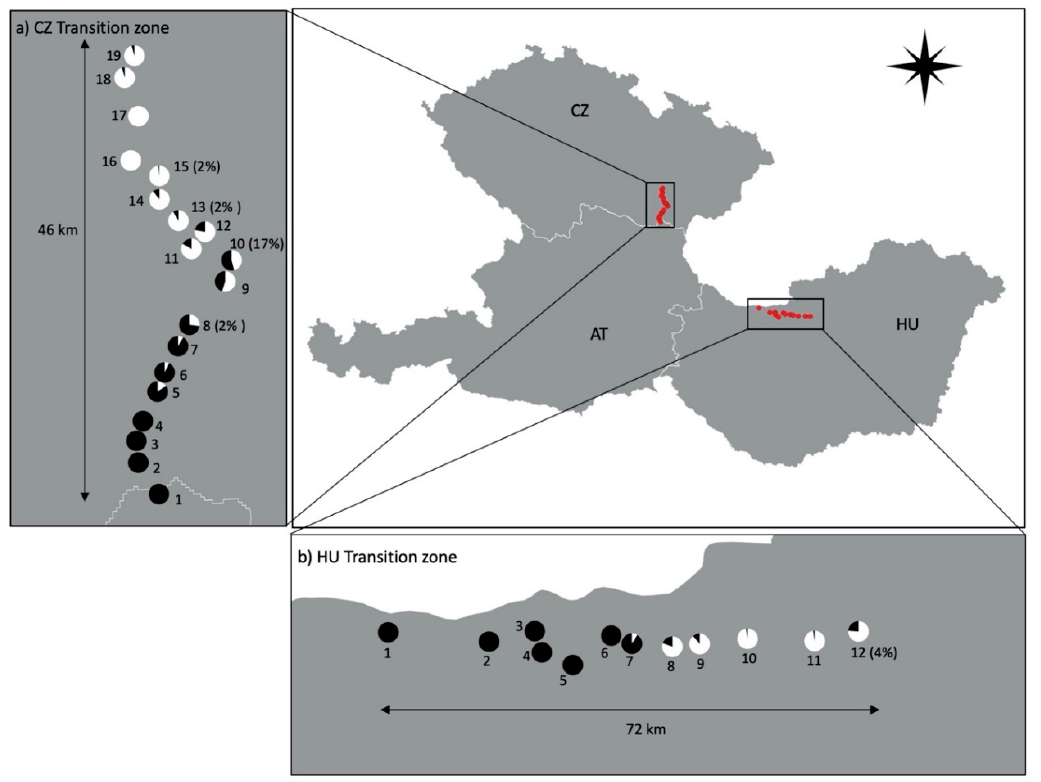
Figure 1. The distribution of Rhagoletis cerasi mitochondrial haplotypes, HT1 and HT2, in two w Cer2 transition zones within the Czech Republic (CZ), Hungary (HU) and Austria (AT). White and black pie-charts denote HT1 and HT2 frequencies, respectively. Percentages in parentheses indicate frequencies of misassociated HT1 flies infected with w Cer2.